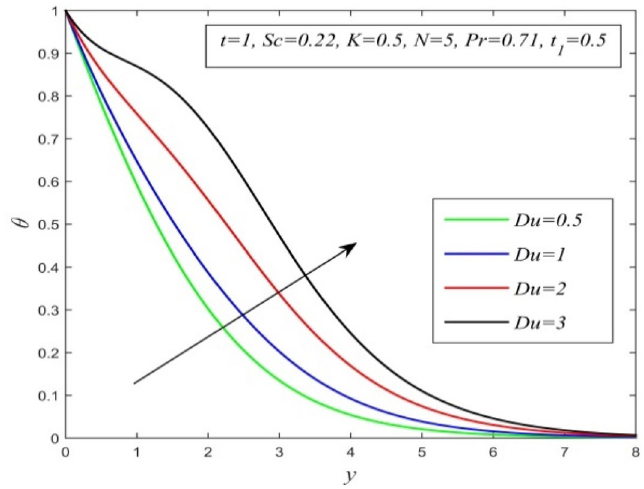
Figure 7. θ versus y for different Du and t = 1, Sc = 0.22, K = 0.5, N = 5, Pr = 0.71, t 1 = 0.5.